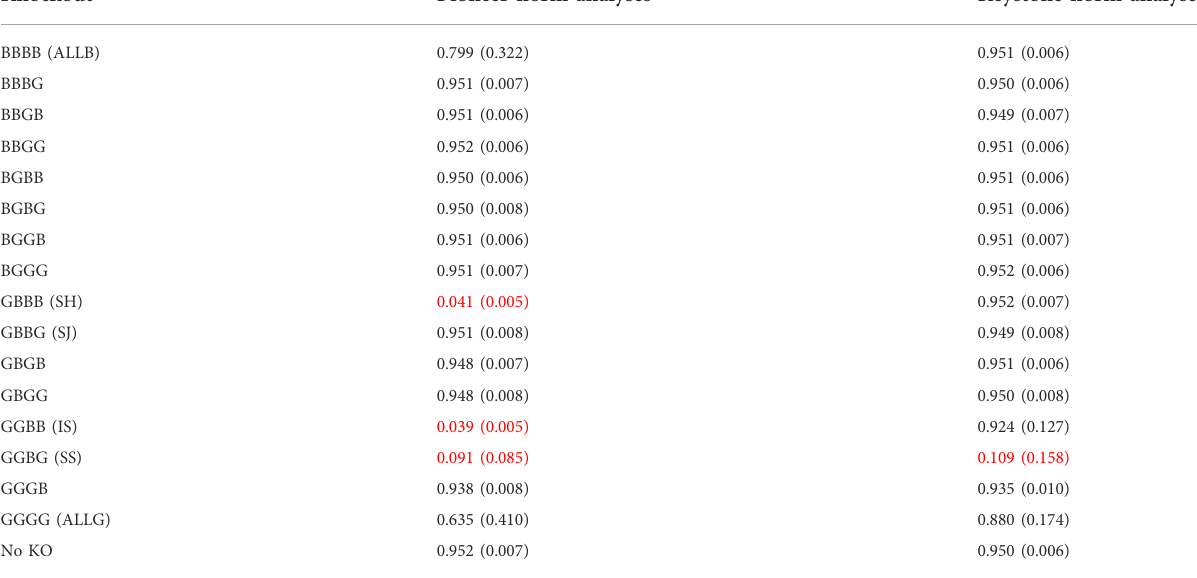
TABLE3Averagecooperationratiosatthe fi nalgeneration.Figuresbetweenparenthesesindicatestandarddeviations.Itishighlightedinredthatthe cooperation ratio falls below 0.2. It shows that average of cooperation ratio after 1,000 generations in pioneer norms analysis and average of cooperation ratio after 2000 generations in keystone norms analysis. In both the analyses, the number of replications is